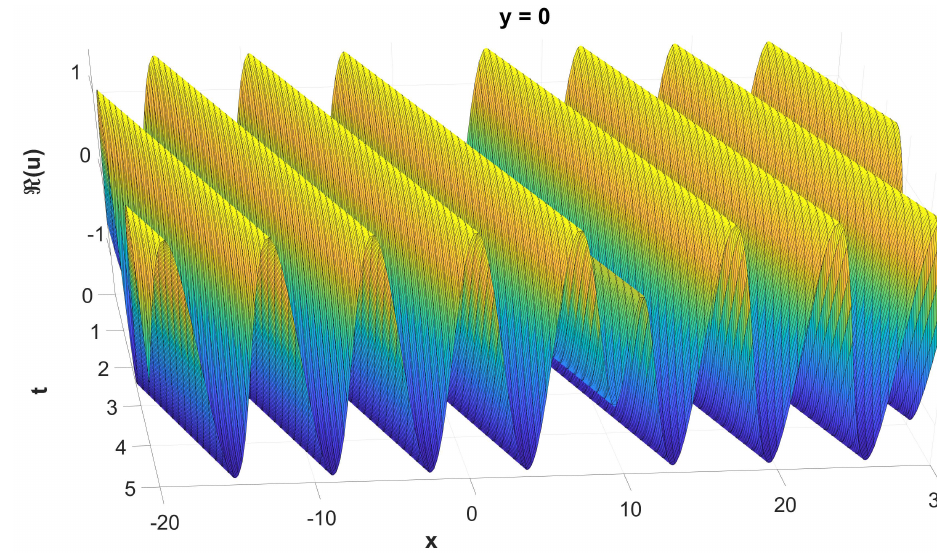
(cid:0) (cid:1) u ( x , y = 0, t ) , evaluated numerically.